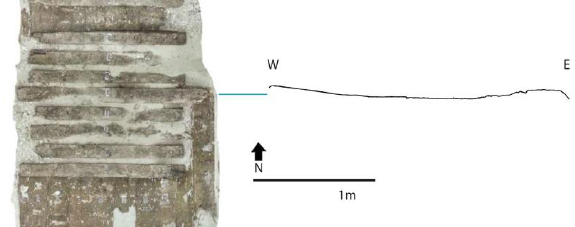
Figure 7. On the left, the blue stripe indicates the frame F22. On the right, an illustration of a section depicting the middle of the F22 frame created directly from the photogrammetric model (photogrammetry and CAD: Bruno Derenne/Georges Verly).